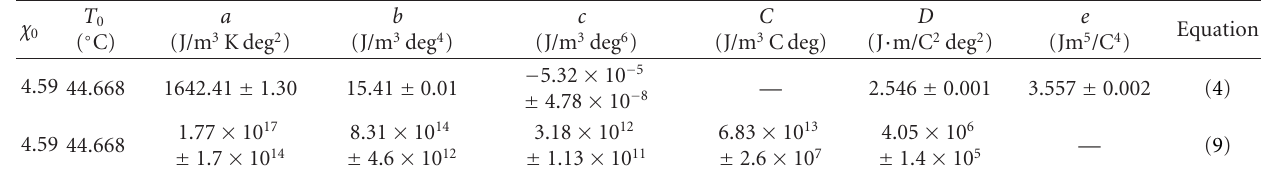
Table 2: Values of the parameters given in the equations indicated for the AC ∗ transition in a mixture of 70PDOB+C7 near the tricritical point ( X = 16 .